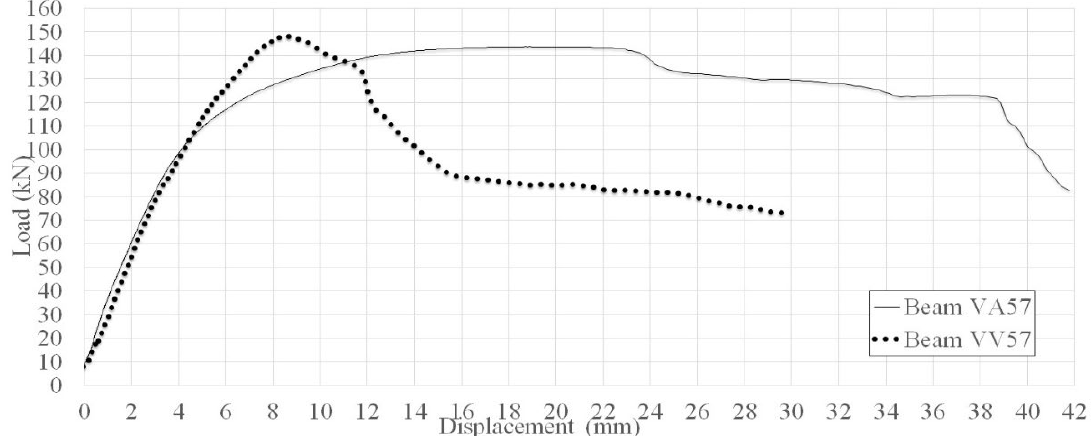
Figure 11. Load vs displacement curves of the 57 kN